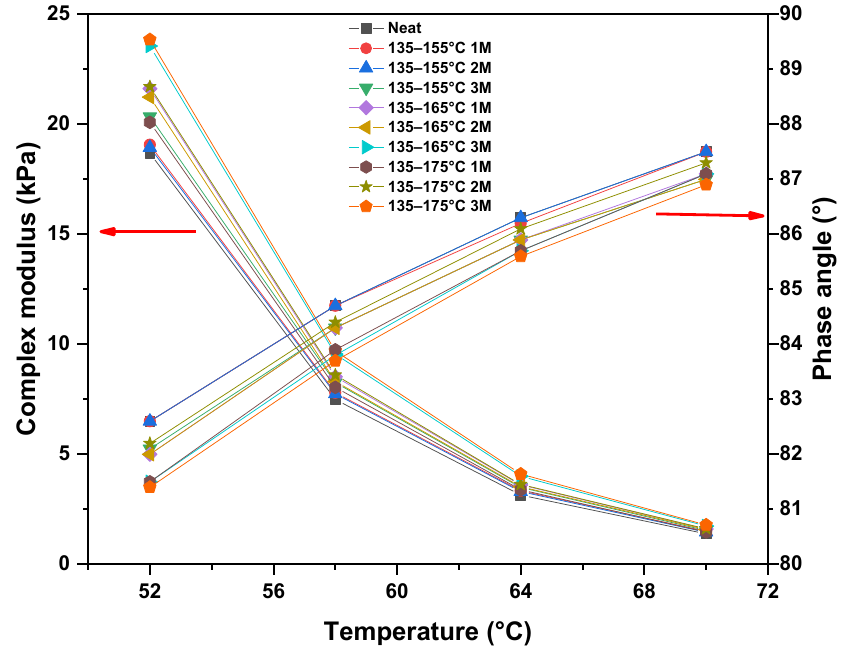
Figure 21. Complex modulus and phase angle under different temperatures at the RTFOT-aged stage.